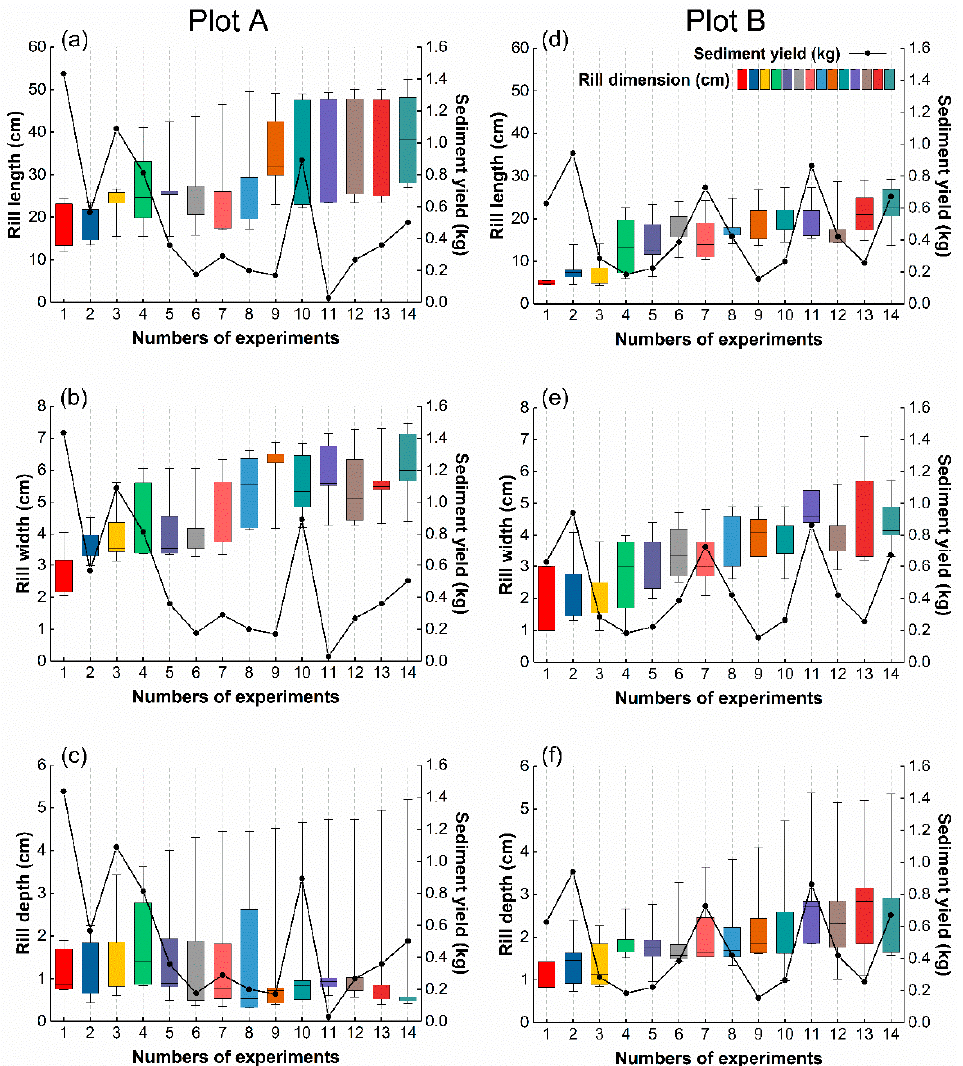
Figure 7. Changes in the dimension (i.e., length, width, and depth) of the rills on hillslopes of plot A ( a – c ) and plot B ( d – f ) over the entire course of 14 experiments, and the sediment yield from hillslopes of plots A and B during each of the experiments.